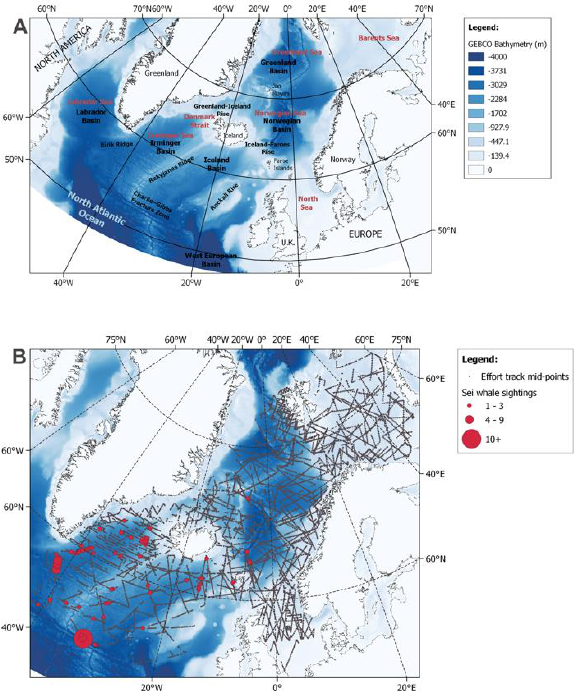
Figure 2. Central and eastern North Atlantic. Background bathymetry is from GEBCO 2014. Projection is UTM30N. Panel A. Map showing place names referred to in the text. Panel B. Survey effort (grey dotted lines) and sightings of sei whale groups (red circles) in the complete dataset for NASS and NILS 1987-2015. The size of the circle for each sighting is representative of the best estimate of group